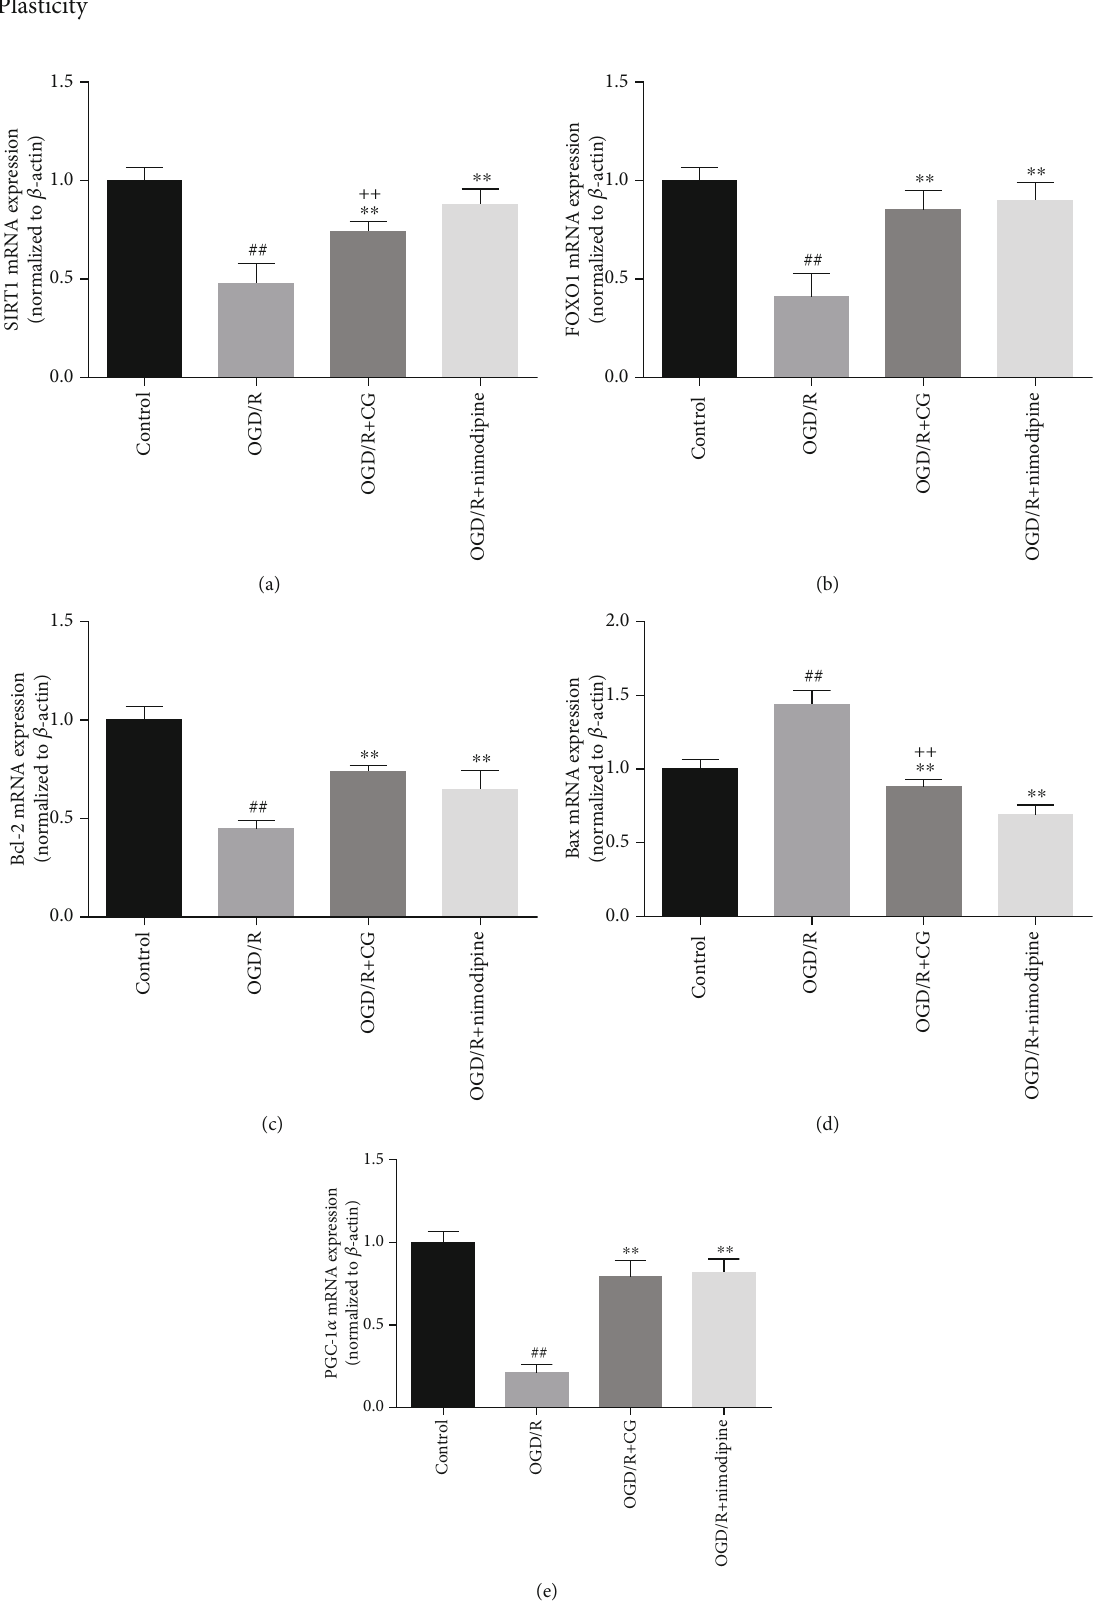
Figure 6: The expression of SIRT1 (a), FOXO1 (b), Bcl-2 (c), Bax (d), and PGC-1 α (e) mRNA after HT22 cells were treated with 8 h of OGD and reoxygenated in the presence of CG for 6 h. Three independent experiments were performed, and data were expressed as the mean ± SD . ## P < 0 : 01 vs. control group; ∗∗ P < 0 : 01 vs. OGD/R group; ++ P < 0 : 01 vs. nimodipine